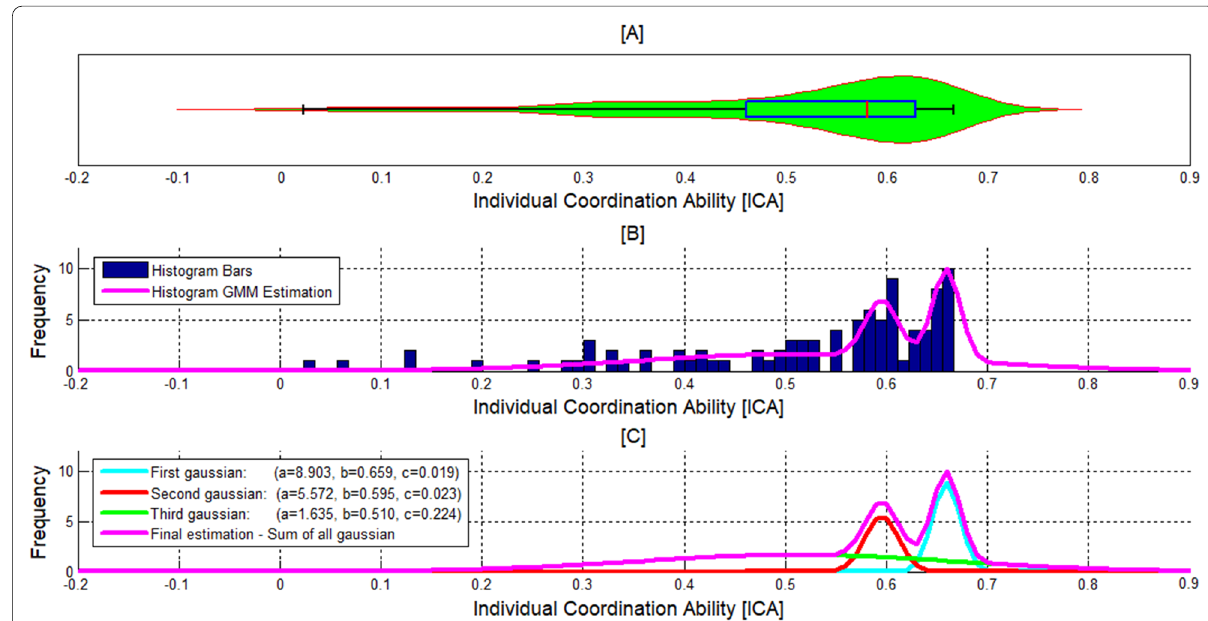
Fig. 3 The distribution of the iCA scores. A Violin plot with boxplot. B Histogram. C Gaussian mixture model estimation. The abscissa is the ICA score. Note that the third Gaussian (green line) is obscured by the general model because of its high variability